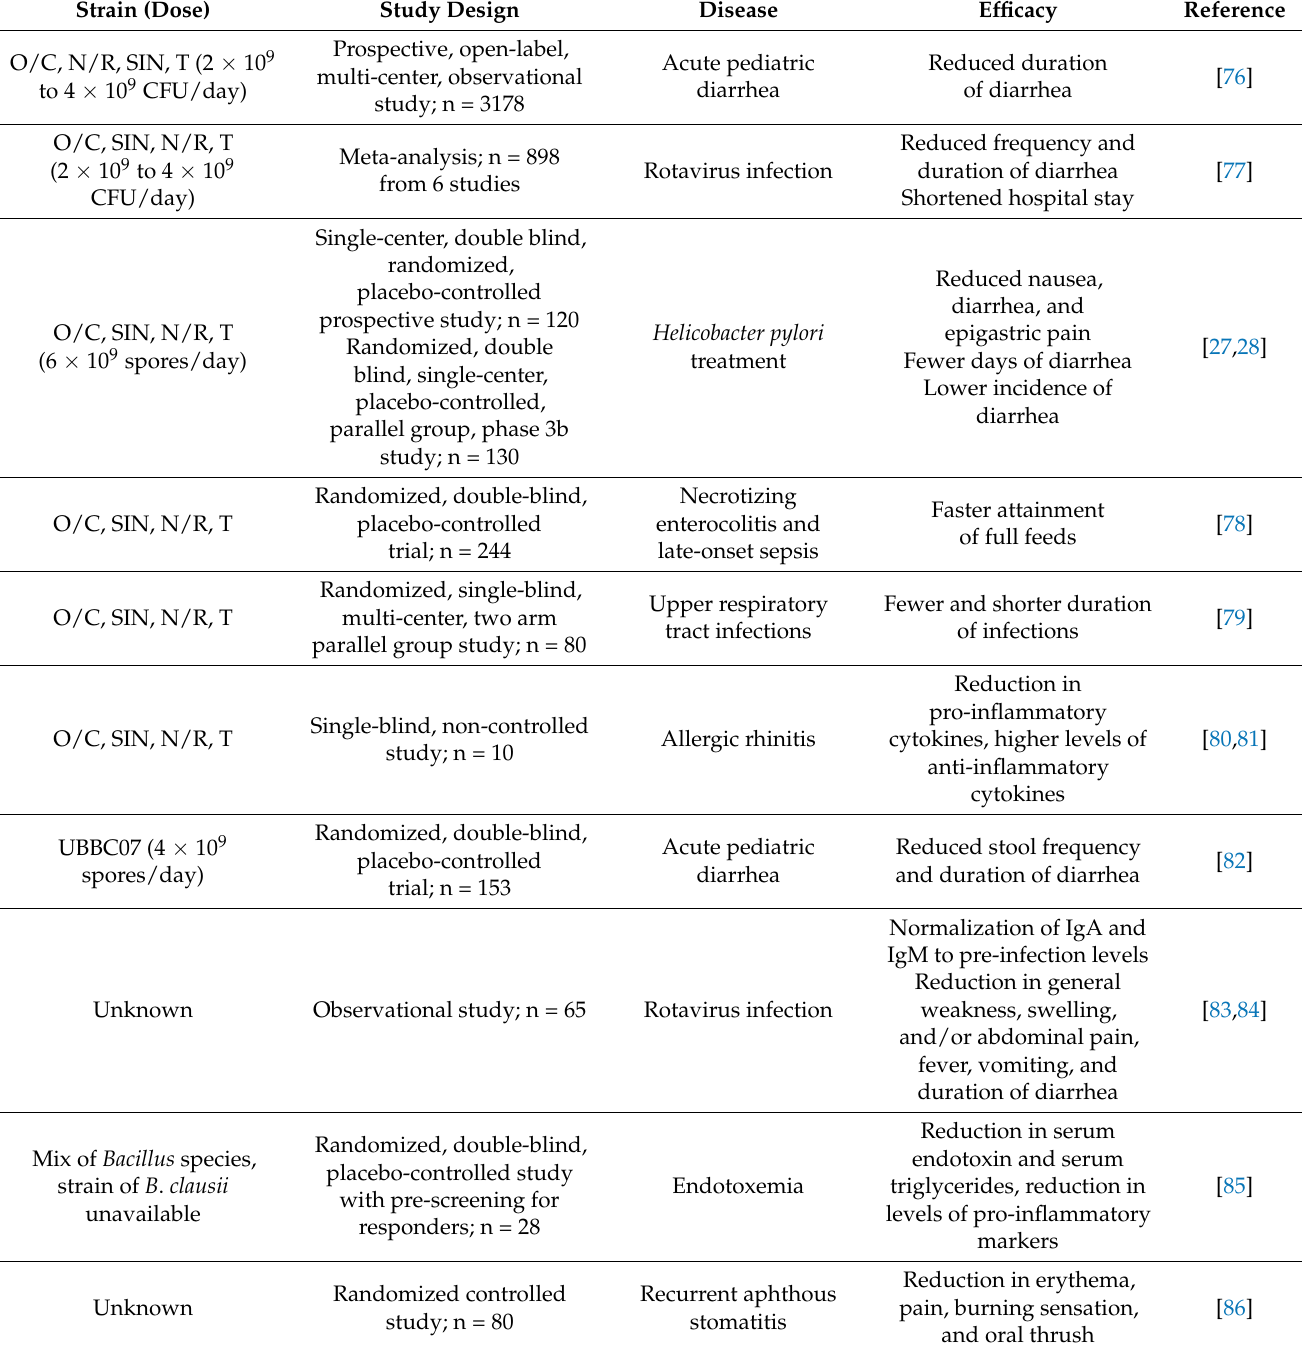
Table 3. Clinical benefits of B. clausii